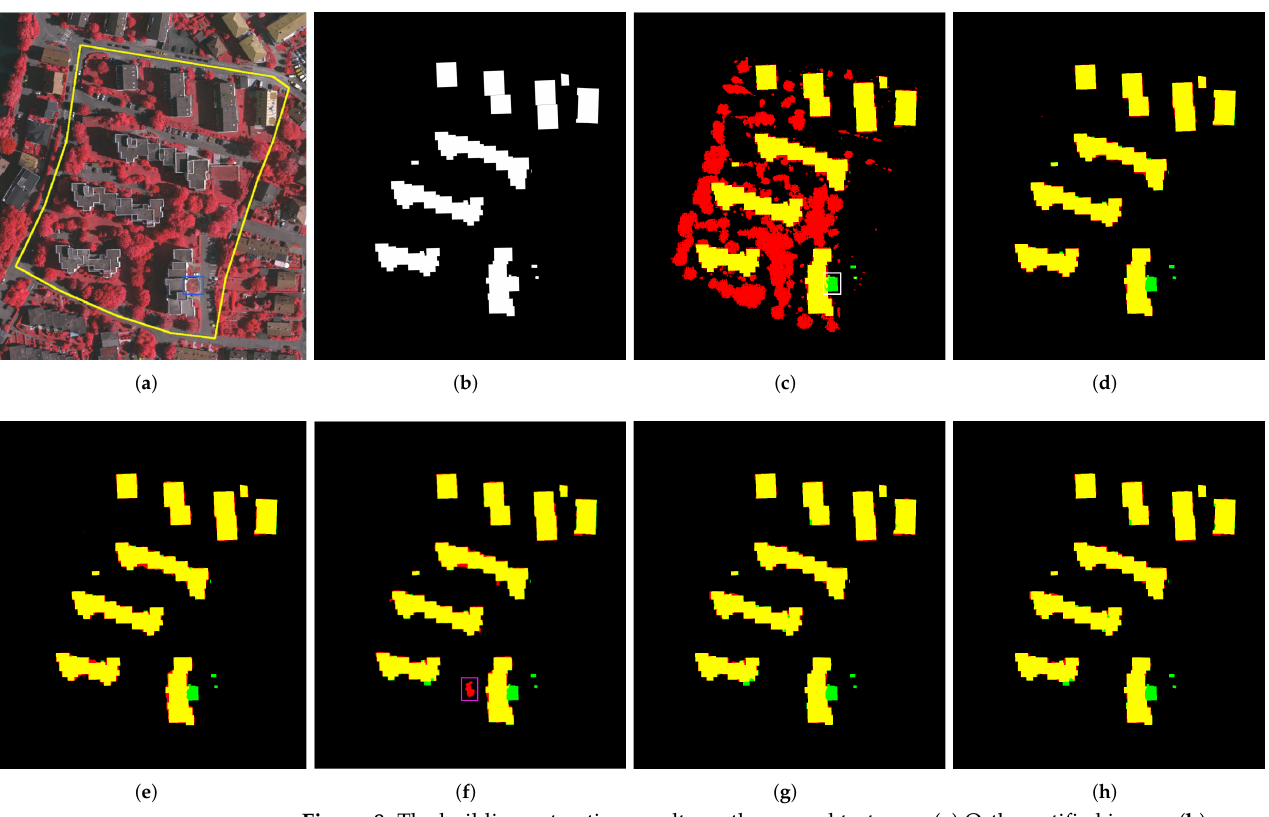
Figure 8. The building extraction results on the second test area. ( a ) Orthorectified image; ( b ) ground truth (white regions denote the buildings); ( c ) nDSM; ( d – h ): result of DeepLabv3+, U-Net, the HOA method, the beSH+IFCC method and the biSH+IFCC